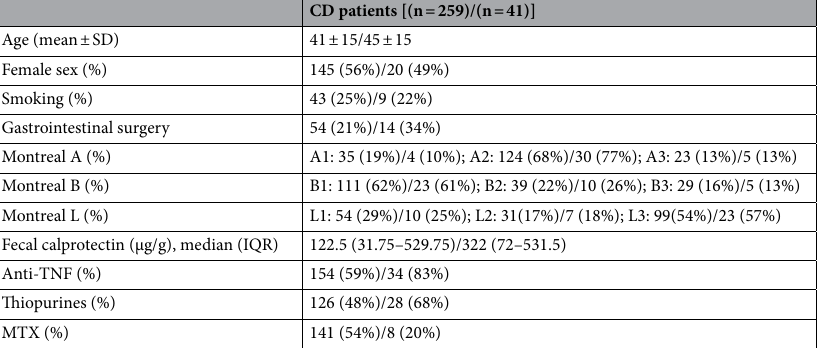
Table 1. Characteristics of the cohort (n = 259 patients/n = 41 patients). Montreal A (age at diagnosis): A1: < 16 years; A2: 17–40 years; and A3: > 40 years. Montreal L (disease location): L1 ileum; L2 colon; L3 ileum–colon. Montreal B (disease behavior): B1 inflammatory; B2 structuring; B3 penetrating. Anti-TNF: infliximab, adalimumab, ustekinumab, vedolizumab. Thiopurines: azathioprine, 6-mercaptopurine. CD Crohn’s disease, MTX